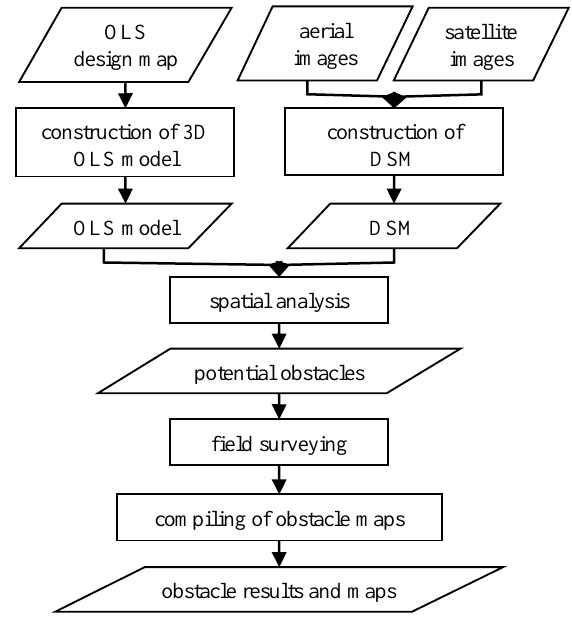
Figure 5. Workflow of the study